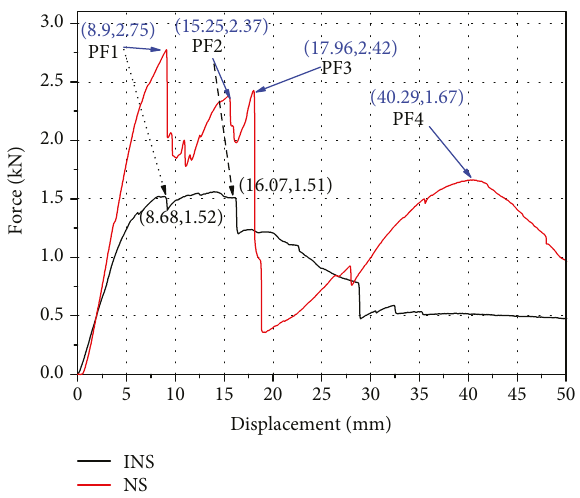
Figure 4: a sectional crushing zone and several cracks.